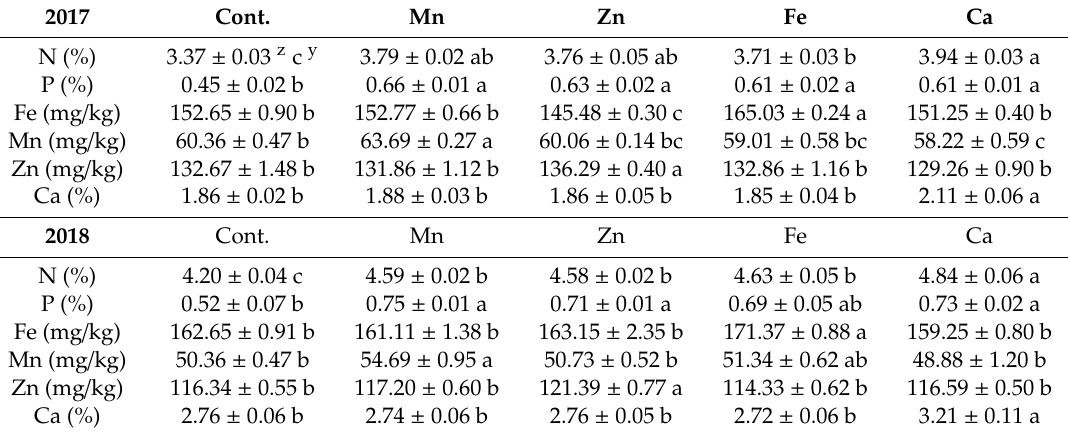
Table 1. E ff ect of foliar application of Ca, Mn, Zn, Fe elements plus water as a control on nitrogen, phosphor, potassium, iron, manganese, zinc, and calcium content of broccoli at harvest